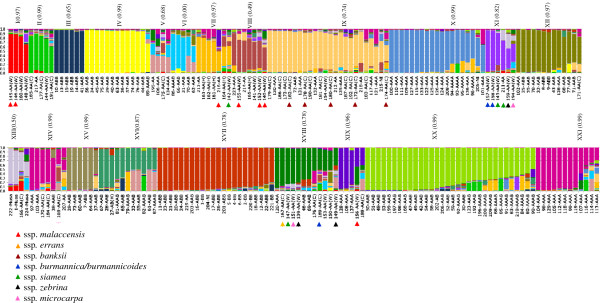
Diversity structure of the 224 Musa accessions based on 16 SSR loci generated by Structure program using the admixture model from matrix derived from Analysis I. The 21 groups (sub-populations) are represented by distinct colors. Each column represents one accession that can be fractionated into segments, whose size is proportional to the estimated membershipfractions (q) in k clusters. Genomic constitutions were based on morphological descriptors (Table 1; Additional file 1: Table S1). Correlation values (r) with the alternative Analysis II used are shown in parenthesis. C: cultivated; W: wild; H: hybrid.